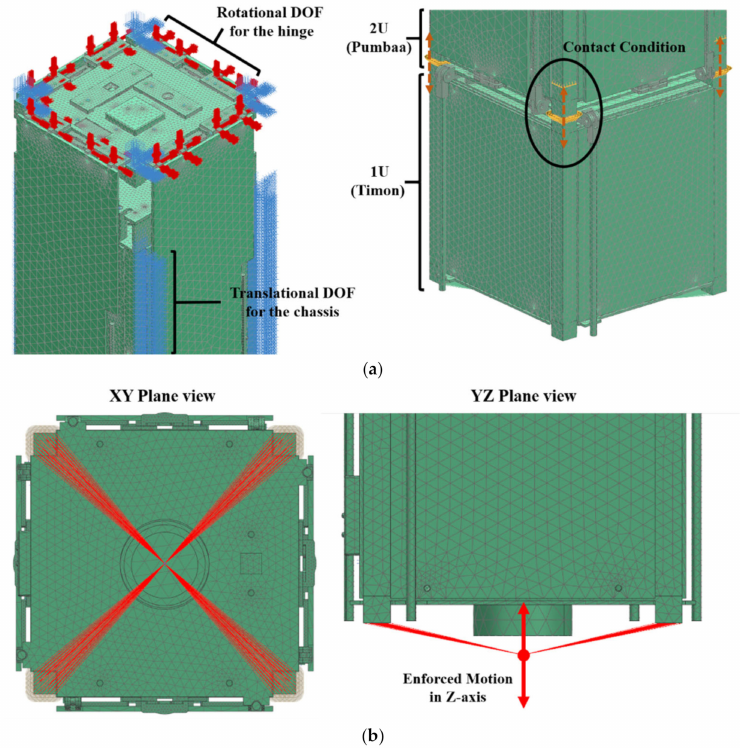
Figure 5. Analysis condition settings: ( a ) DOF constraints and contact conditions; ( b ) XY Plane view and YZ plane view of enforced motion for Z-axis modal